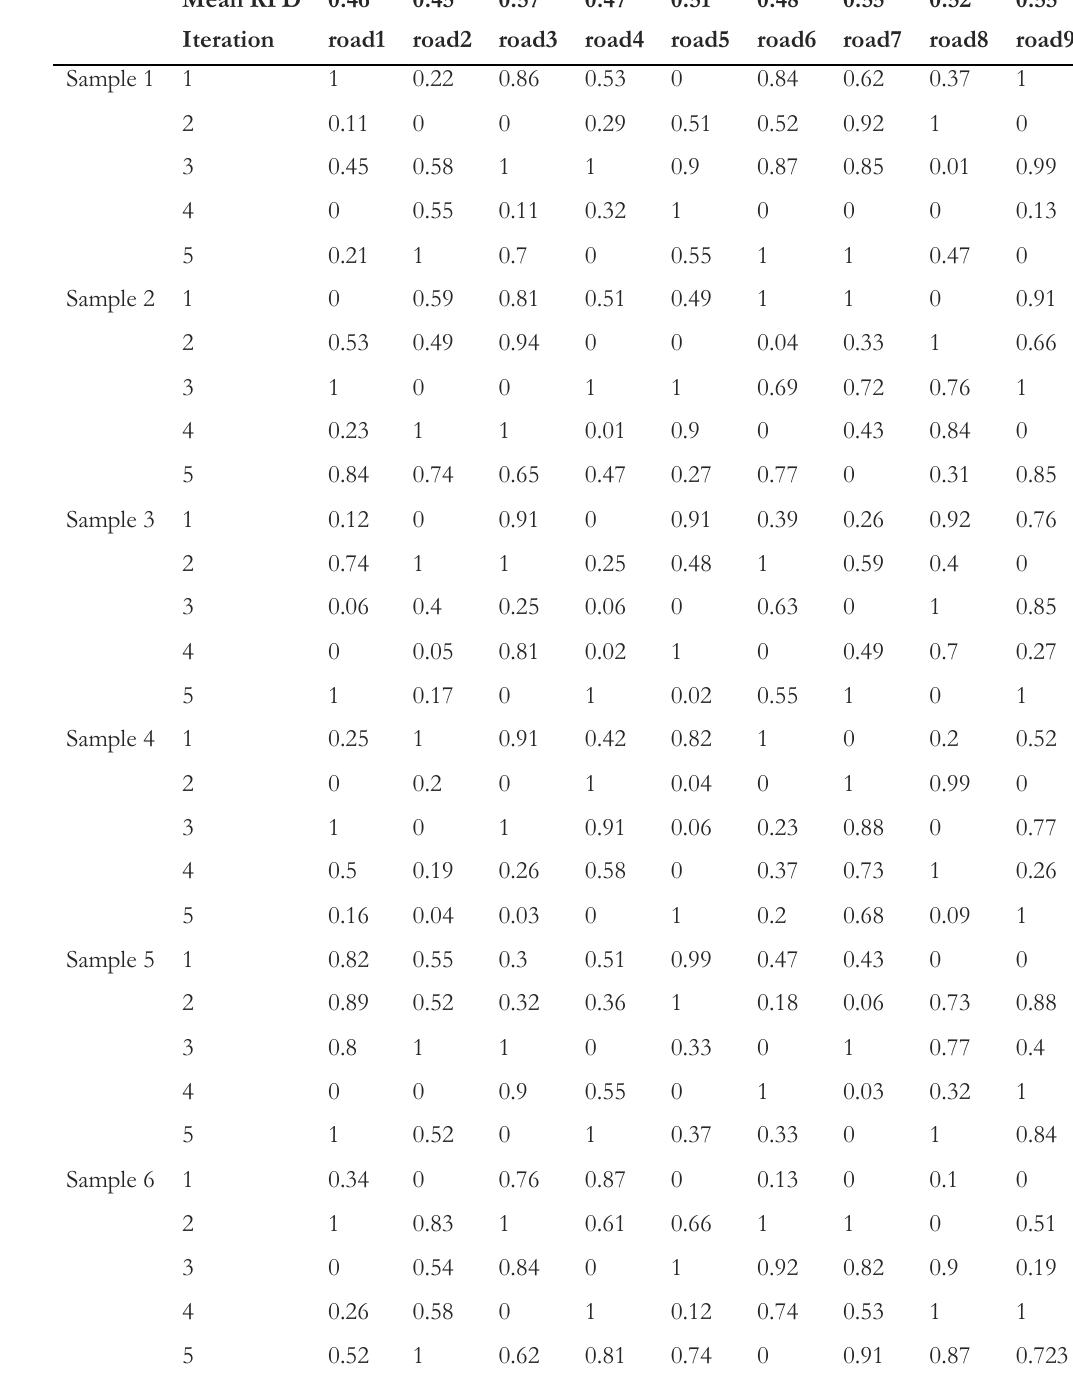
Table 16. RPD results from the ICAVNS